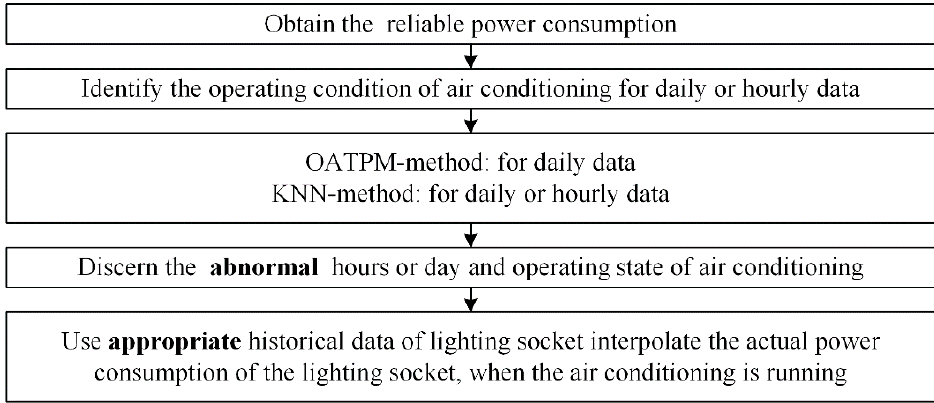
Figure 10. Scatter diagram of hourly electricity consumption of lighting sockets in Building A.